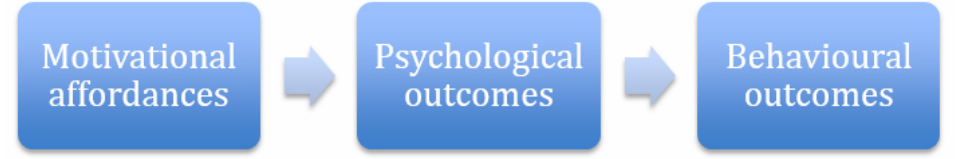
Figure 5. Gamification features (adapted from Hamari et al